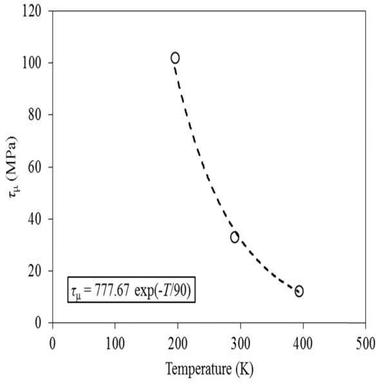
Temperature-dependence of thermal stress offset term: comparison of exponential fit with experimentally-based results.